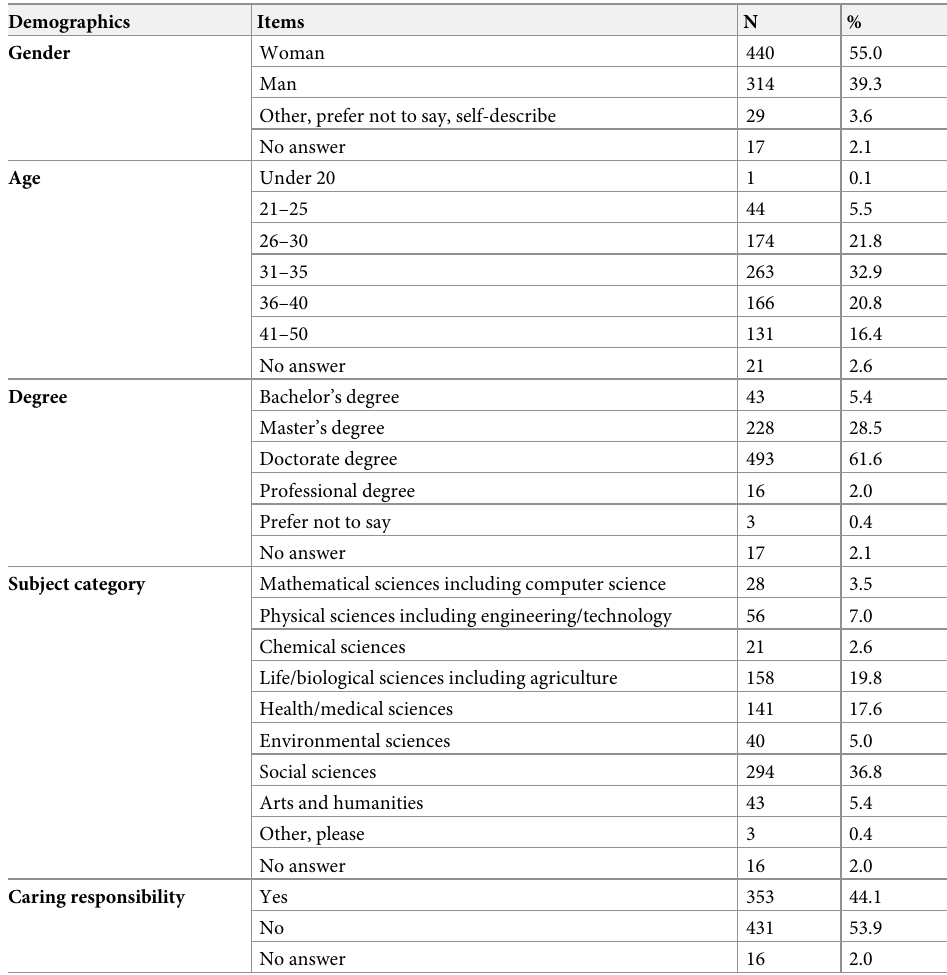
Table 1. Demographics of